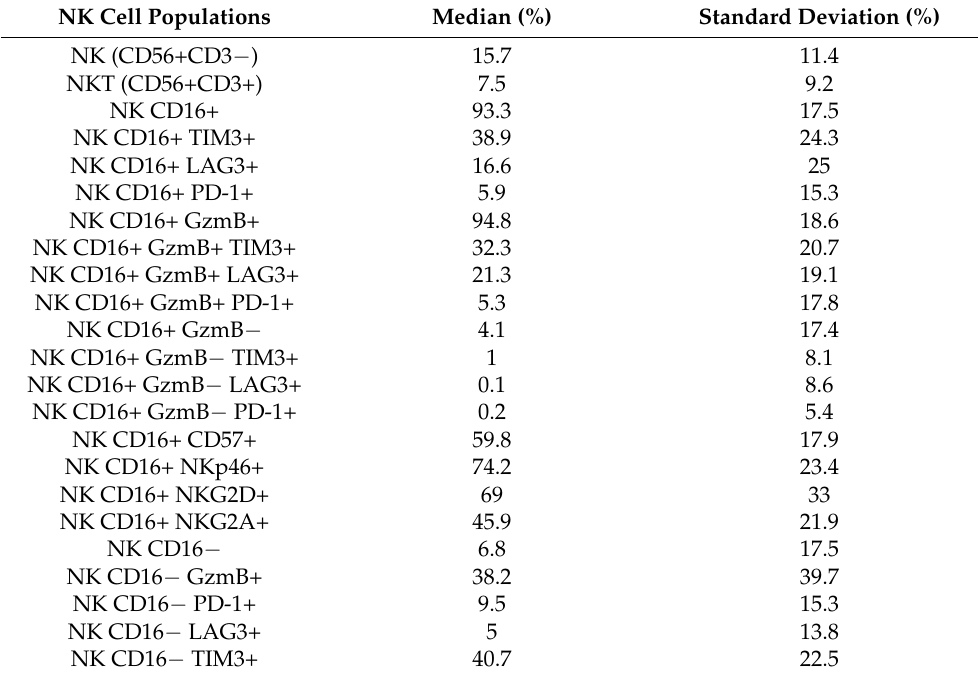
Table 3. Distribution of NK cell